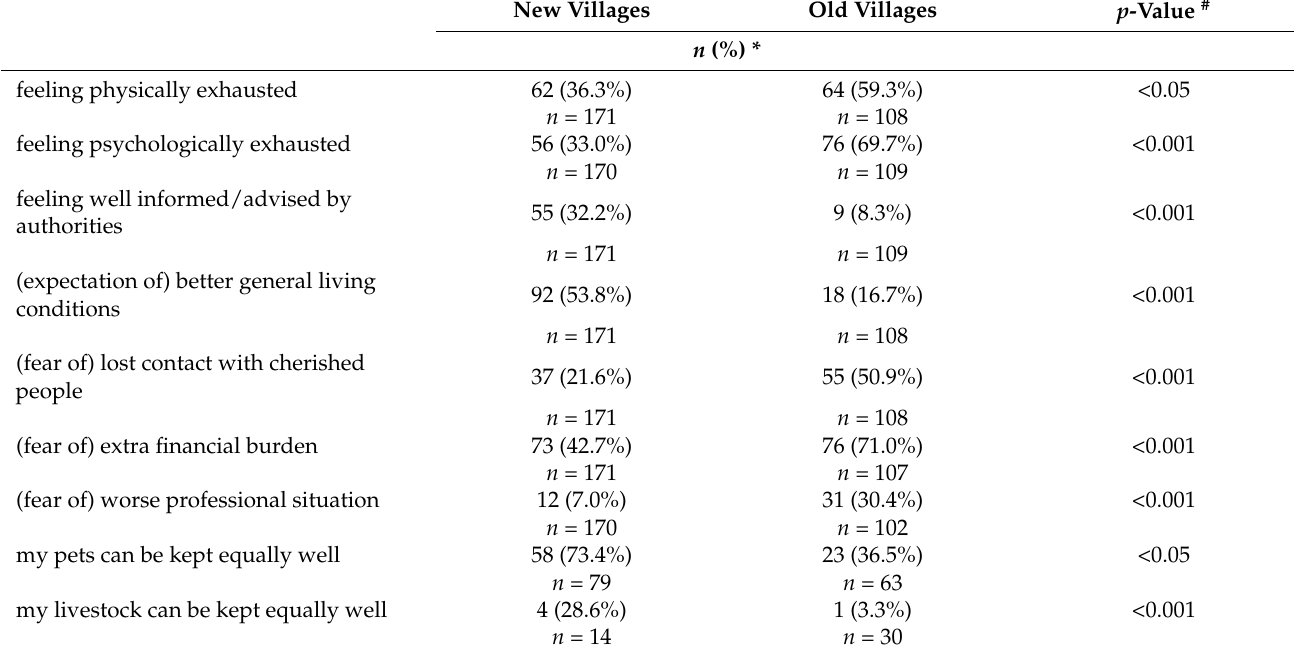
Table 4. Experienced or expected Impacts of Resettlement. New